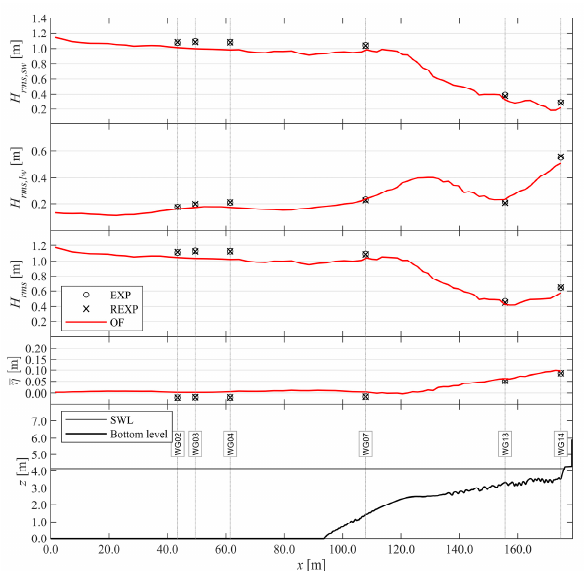
Figure 8. Comparison of H rms between OF and (R)EXP up to the dike toe. From top to bottom: H rms,sw for the SW components, H rms,lw for the LW components, H rms for the total η , the wave setup 𝜂̅, and finally an overview of the sensor locations, SWL , and bottom profile.